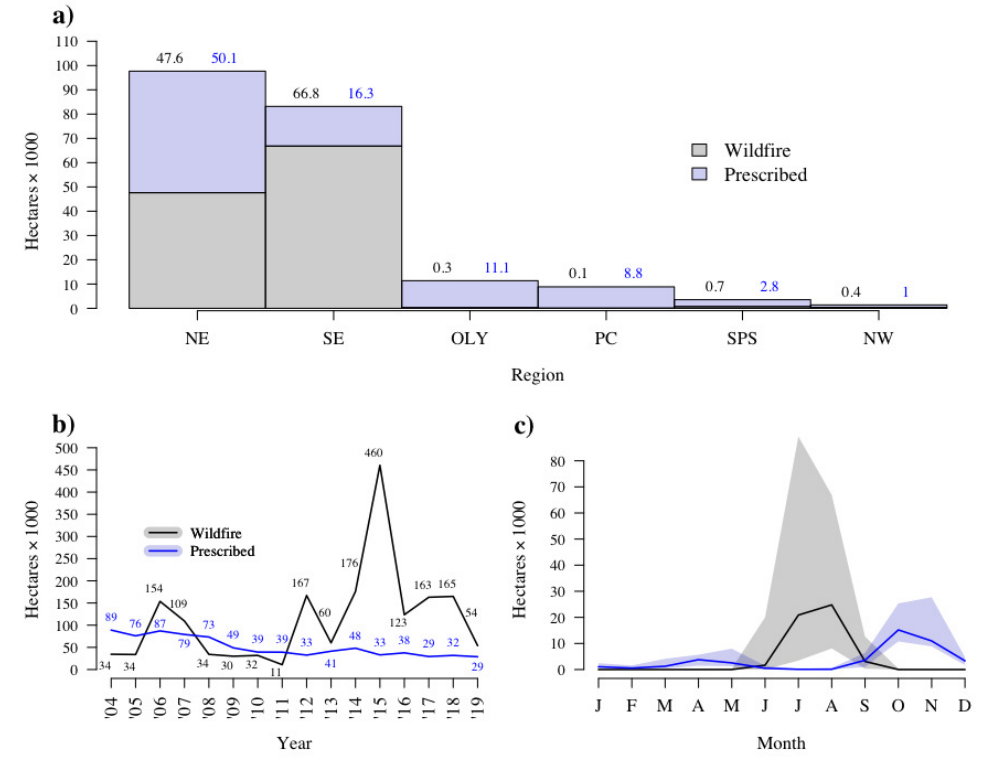
Figure 2. Spatial and temporal variability in area burned from wildfires and prescribed fires for the years 2004–2019. Panel ( a ) shows the mean annual area burned by wildfire and prescribed fire disaggregated by DNR administrative region (Northeast (NE), Northwest (NW), Olympic (OLY), Pacific Coast (PC), South Puget Sound (SPS), and Southeast (SE). Panel ( b ) shows the annual area burned disaggregated by year and panel ( c ) shows the mean monthly area burned. In ( c ) the interval represents the central 80th percentile of values between 2004–2019 and the solid line represents the